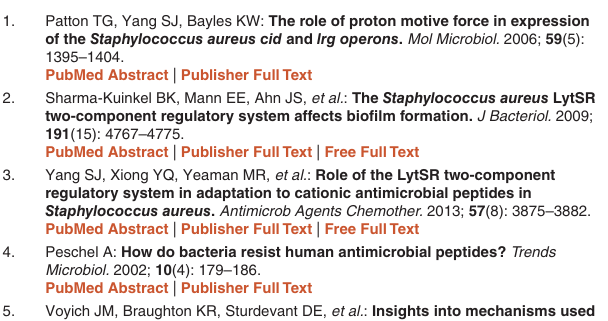
Figshare: Raw data for the role of acetyl phosphate in bypassing the cell membrane electrical potential sensor LytS doi: 10.6084/ m9.figshare.1339843 39